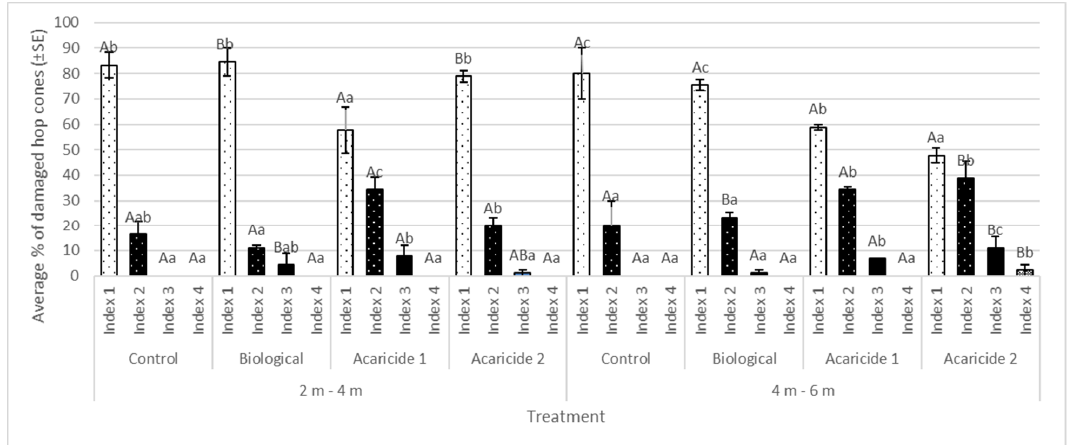
Figure 3. Average per cent of damaged hop cones according to sampling height and treatment (lowercase letters: for comparison at one sampling height, between treatments according to the same damage index (level of damage) (df = 3,11;